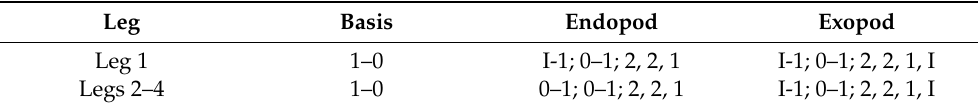
Figure 4. Caromiobenella brasiliensis (Dias and Su á rez-Morales, 2000) comb. nov., from Rio de Janeiro area, adult male (MNRJ30136). ( A ) Leg 1; ( B ) Leg 2; ( C ) Leg 3; ( D ) Leg 4. Arrows indicate expanded inner margins of basipod. Table 3. Armature of legs 1–4 including basis, exopods and endopods. Roman numerals indicate spiniform elements, Arabic numbers indicate setiform elements